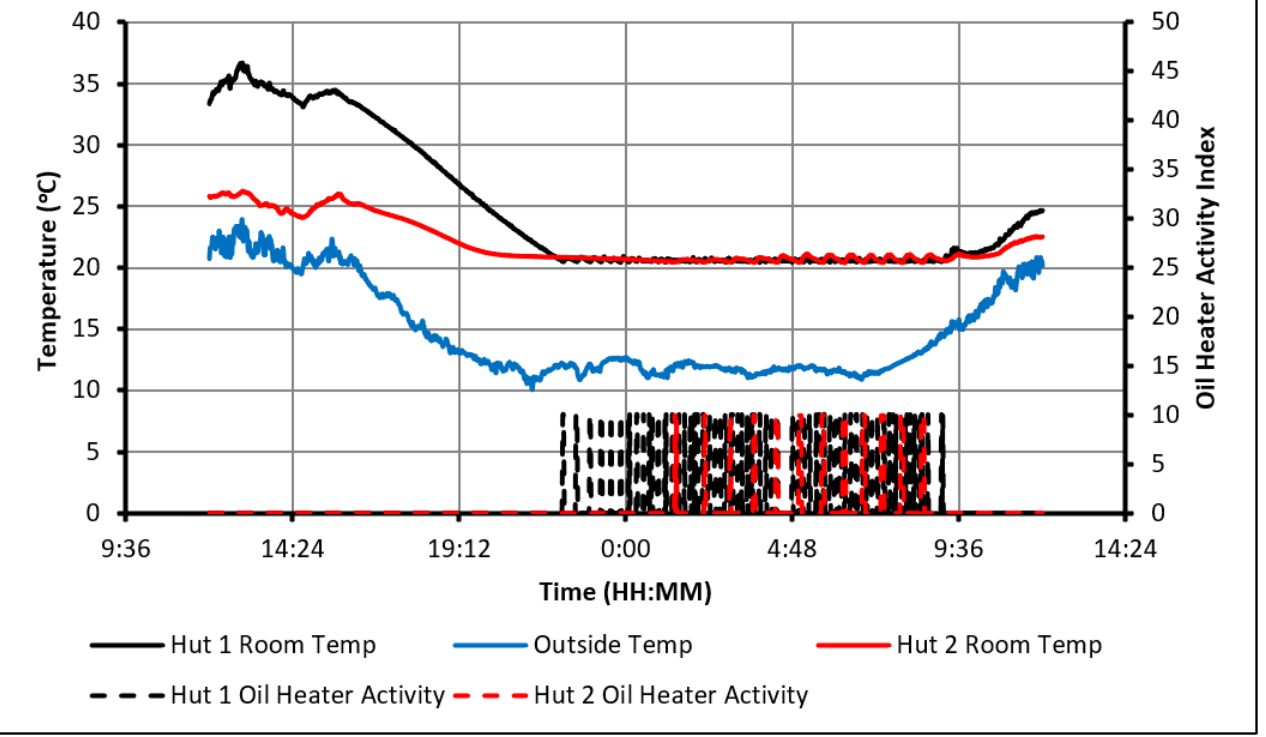
Figure 8. Analysis of heater activity (20 – 22 °C temperature constraint, day 8 and